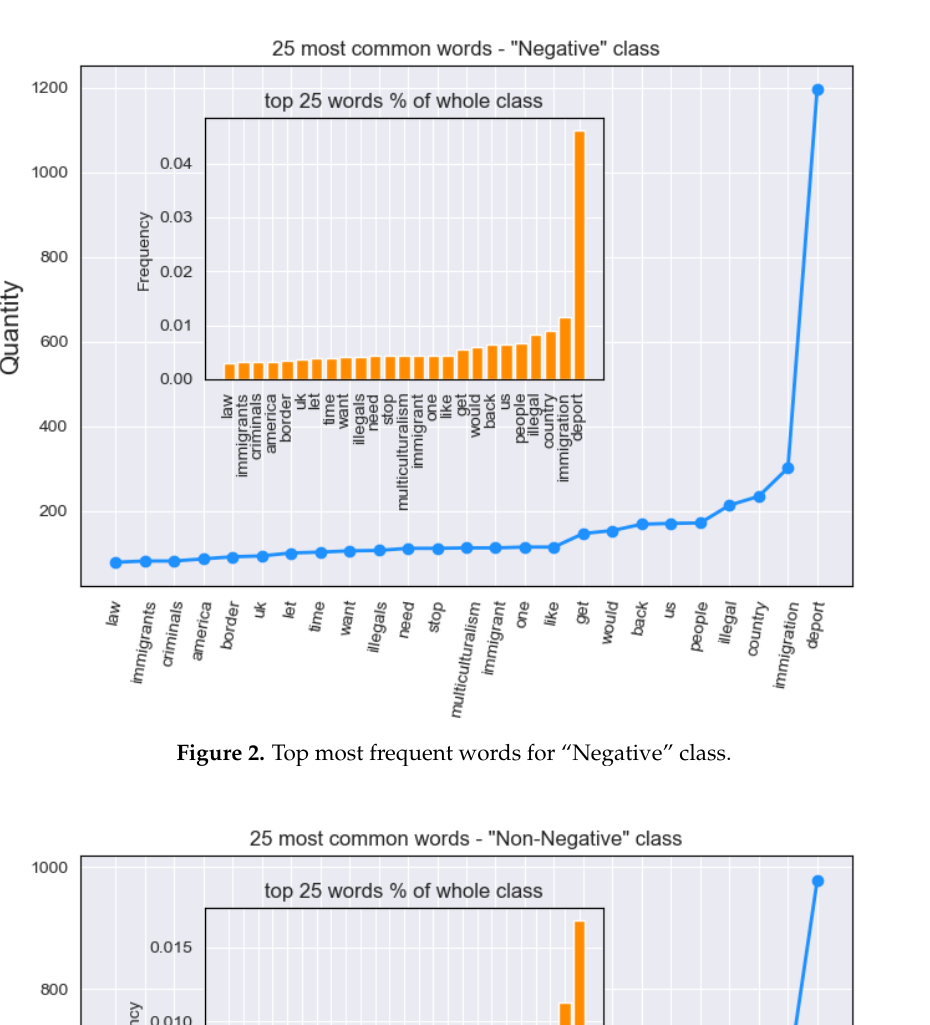
Figure 2. Top most frequent words for “Negative” class.